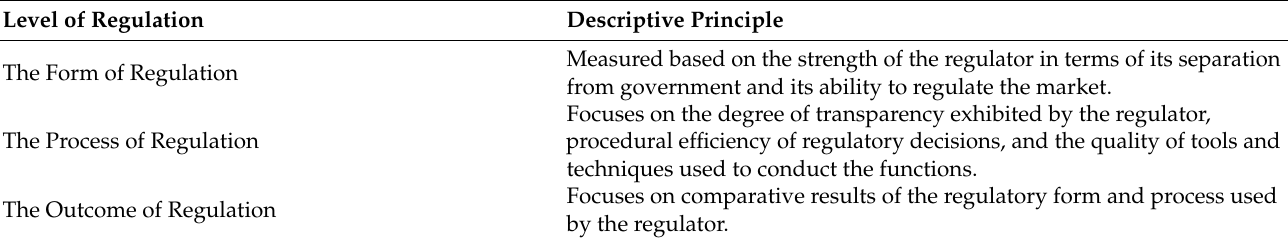
Table 8. Description of forms of regulation.